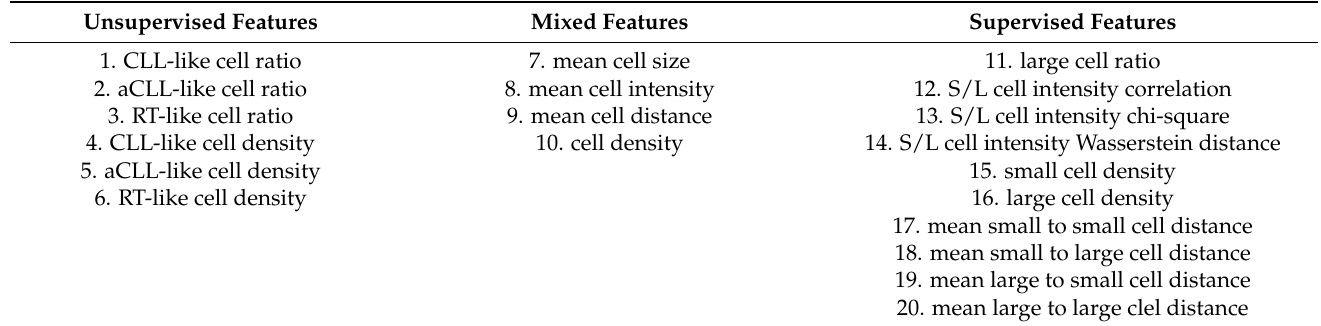
Table 2. Cellular features extracted from unsupervised clustering, mixing, and supervised learning, and termed unsupervised features, mixed features, and supervised features,